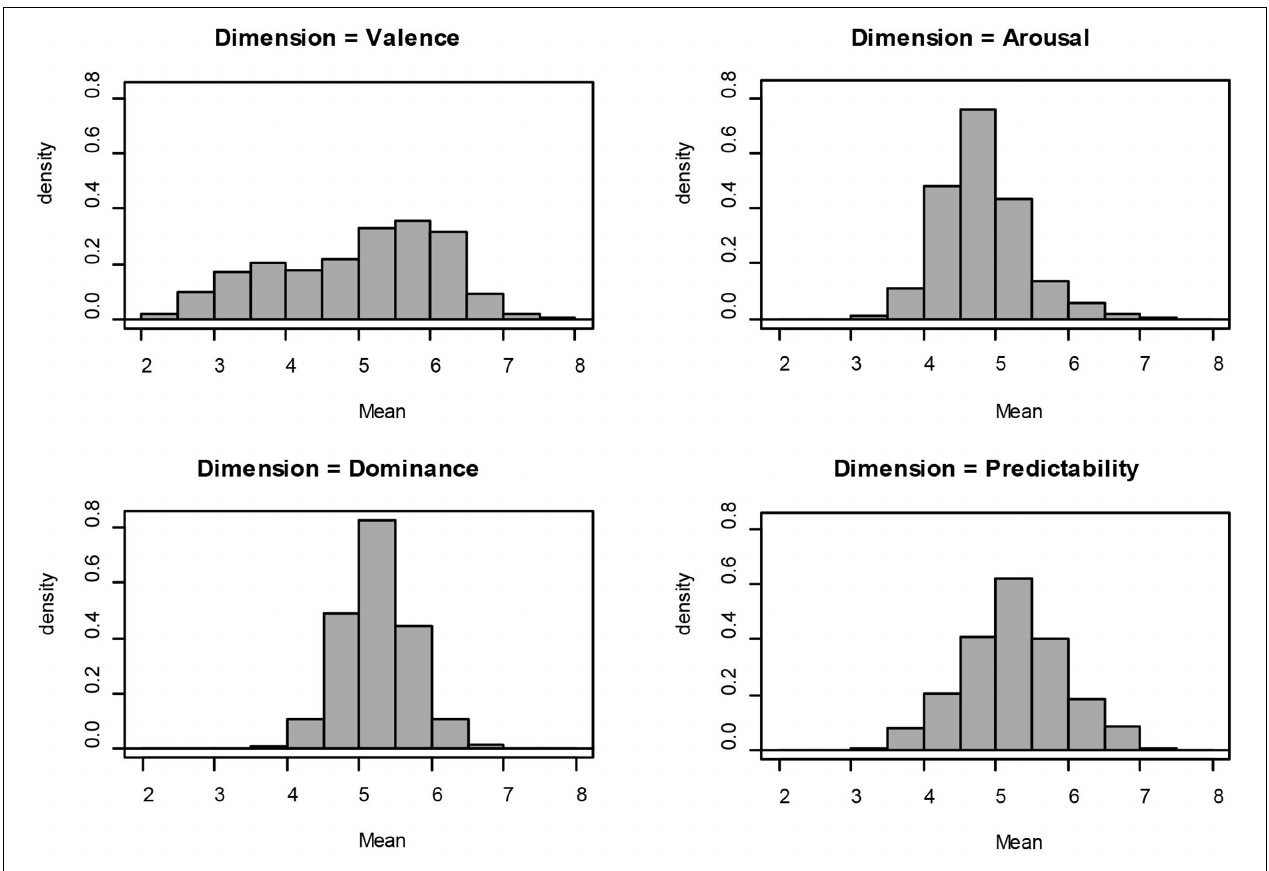
FIGURE 1 | Distribution of emotional dimension